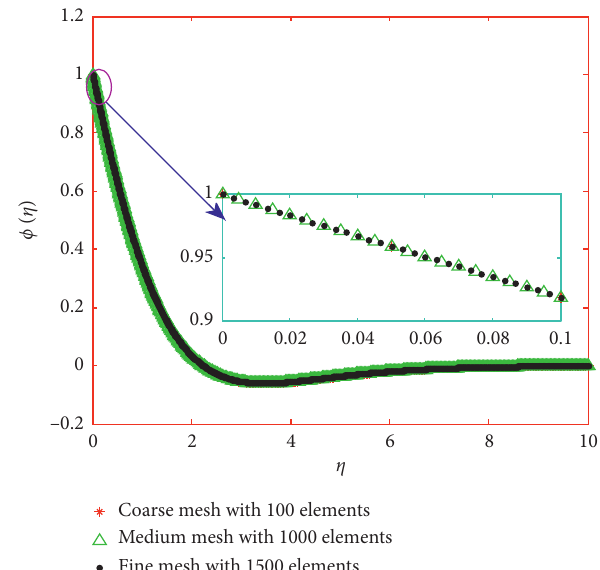
Figure 29: Grid-independence test showing every fifth element of the mesh for concentration